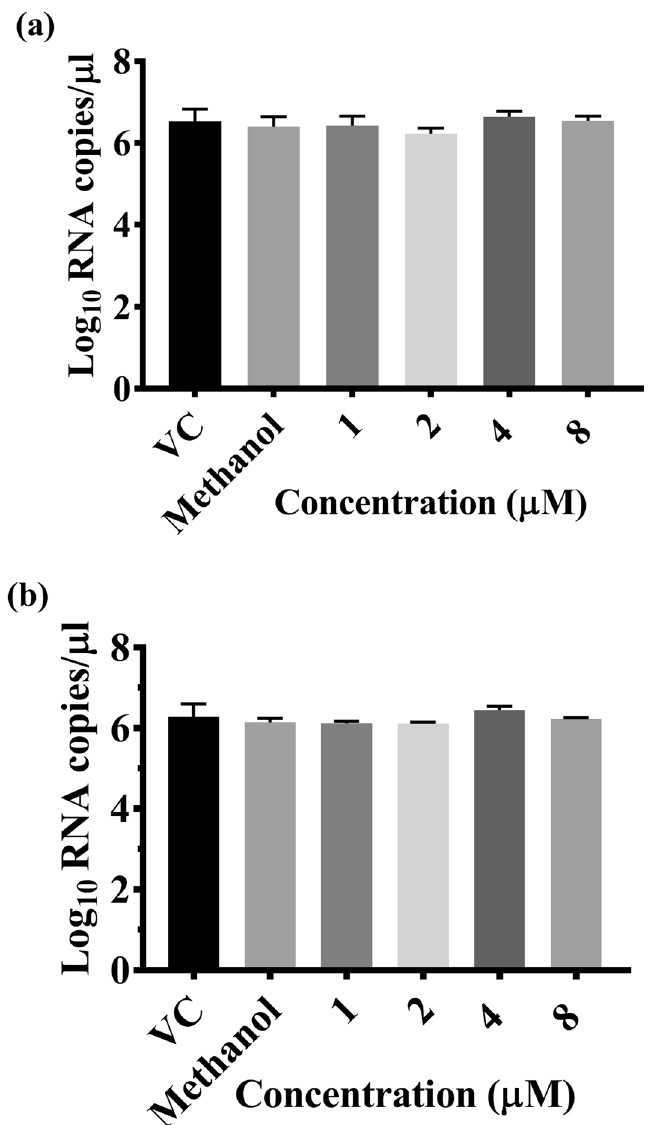
Figure 3. ( a ) Effect of pre-treatment of Vero E6 cells with CA on dengue virus infection and replication expressed in terms of log 10 viral RNA copy numbers. ( b ) Effect of treatment of Vero E6 cells with CA post- infection on dengue virus infection and replication is expressed in log 10 viral RNA copy numbers. VC refers to virus control in which no CA was